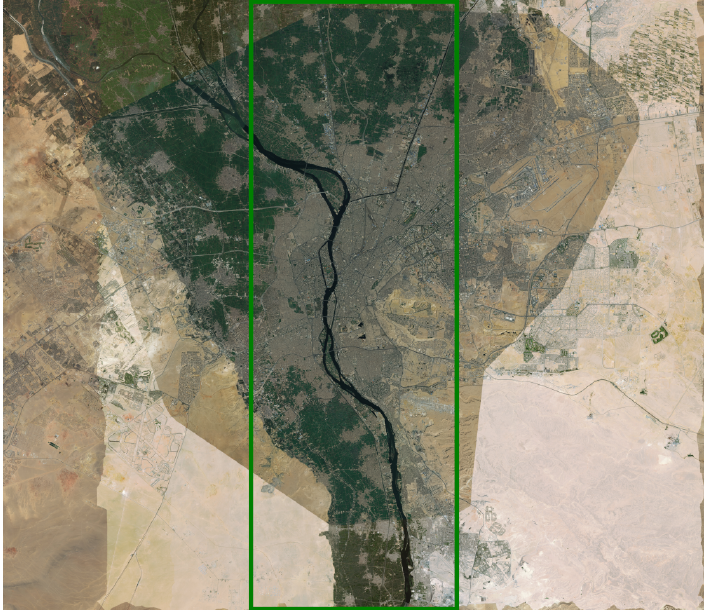
Figure 5. Input Satellite image for Cairo—Source: BING.